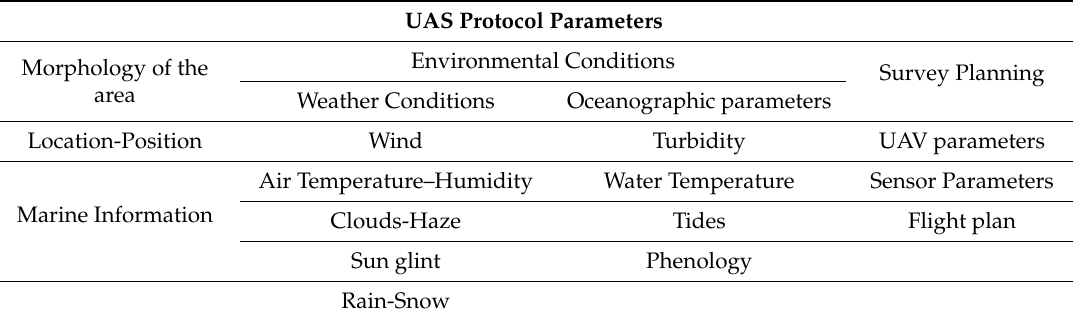
Table 1. Structure of UAS